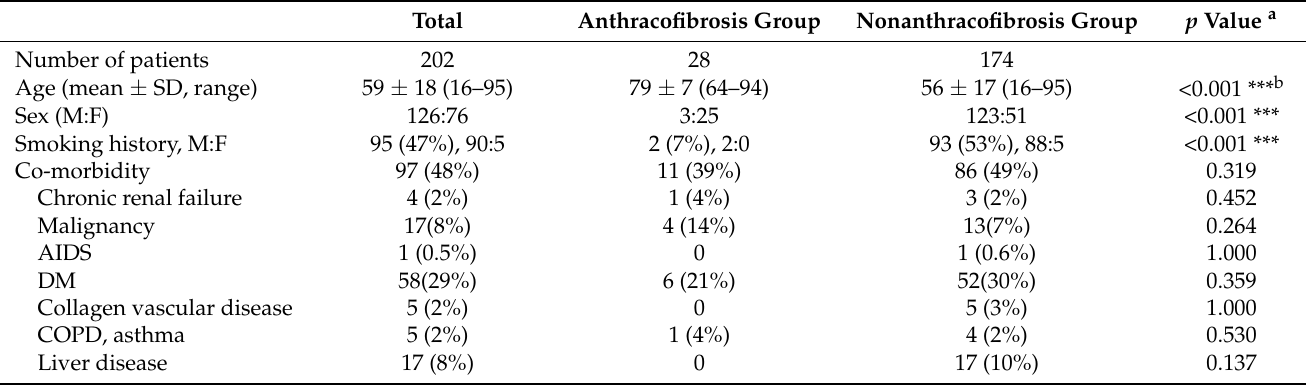
Table 1. The clinical features, microbiology results, and statistical differences between anthracofibrosis group and nonanthracofibrosis